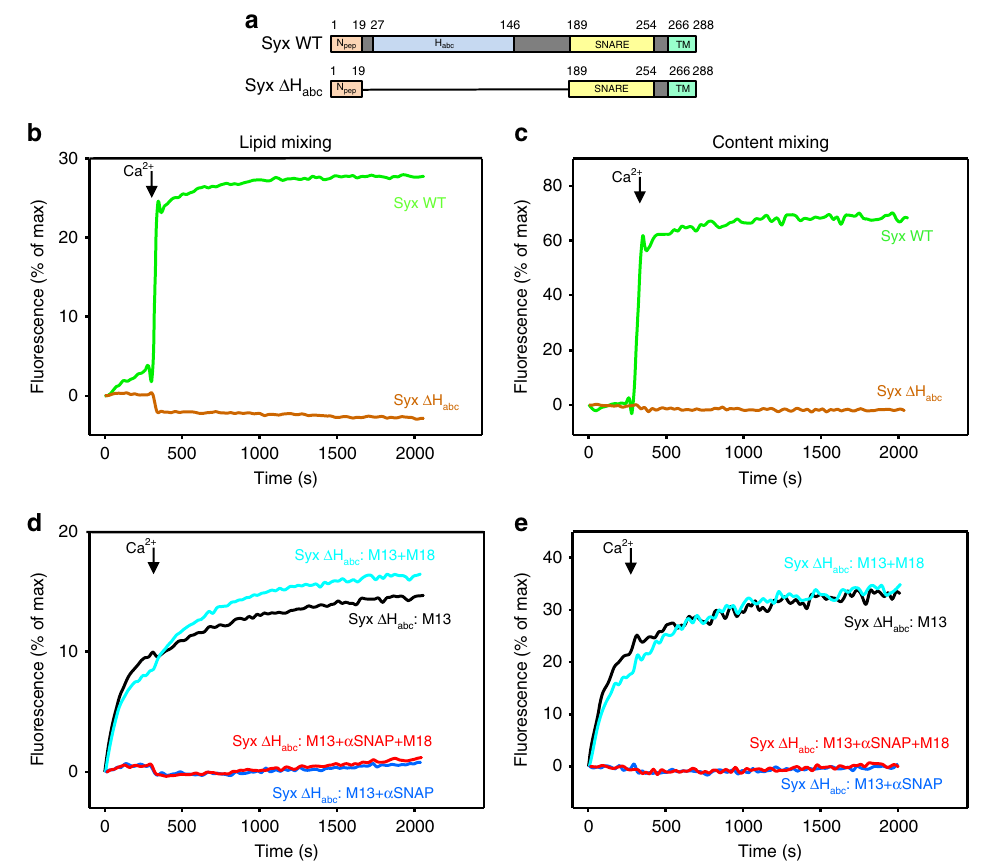
Fig. 5 Binding of Munc18-1 to closed syntaxin-1 is key to overcome the inhibition of fusion by α SNAP. a Domain diagrams of syntaxin-1 showing the design of the syntaxin-1 mutant lacking the N-terminal H abc domain ( Δ H abc ). N pep denotes the N-peptide, H abc the H abc domain, SNARE the SNARE motif, and TM the transmembrane region. b – e Lipid mixing ( b , d ) between V- and T-liposomes was monitored from the fl uorescence de-quenching of Marina Blue lipids and content mixing ( c , e ) was monitored from the increase in the fl uorescence signal of Cy5-streptavidin trapped in the V-liposomes caused by FRET with PhycoE-biotin trapped in the T-liposomes upon liposome fusion. In b , c , assays were performed in the presence of 0.8 µ M NSF, 2 µ M α SNAP, 1 µ M Munc18-1 (M18), and 0.5 µ M M13C 1 C 2 BMUNC 2 C (M13) using T-liposomes that contained WT syntaxin-1 (Syx WT) or the syntaxin-1 mutant lacking the Habc domain ( Δ H abc ). In d , e , experiments were performed with T-liposomes containing Δ H abc syntaxin-1 mutants in the presence of 0.5 µ M M13C 1 C 2 BMUNC 2 C with or without 1 µ M Munc18-1 and with or without 2 µ M α SNAP. Experiments were started in the presence of 100 μ M EGTA, 1 µ M excess of SNAP-25, and 5 μ M streptavidin, and then Ca 2 + (600 μ M) was added at 300 s. Source data are provided as a Source Data fi